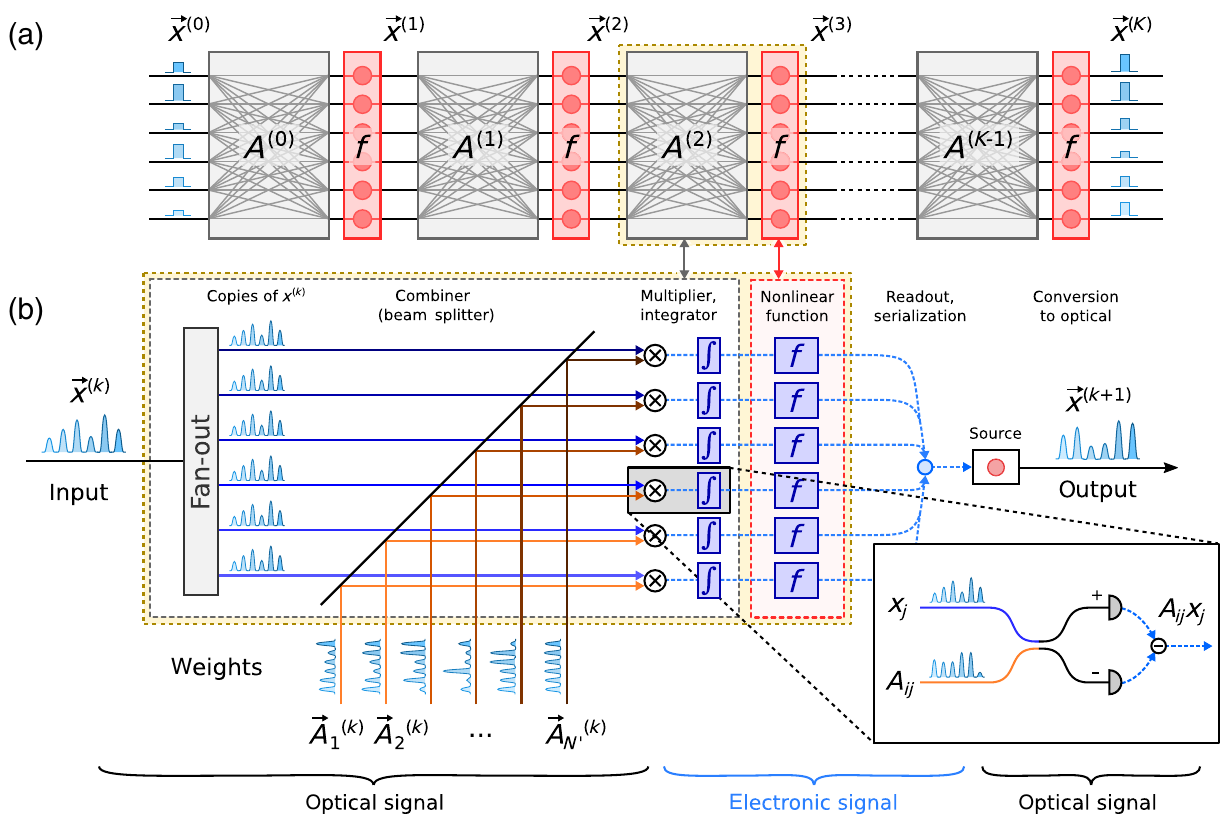
FIG. 1. Schematic diagram of a single layer of the homodyne optical neural network. (a) Neural network represented as a sequence of K layers, each consisting of a matrix-vector multiplication (gray) and an elementwise nonlinearity (red). (b) Implementation of a single layer. Matrix multiplication is performed by combining input and weight signals and performing balanced homodyne detection (inset) between each signal-weight pair (gray box). For details on experimental implementation see Sec. S1 of Supplemental Material [31]. The resulting electronic signals are sent through a nonlinear function (red box), serialized, and sent to the input of the next